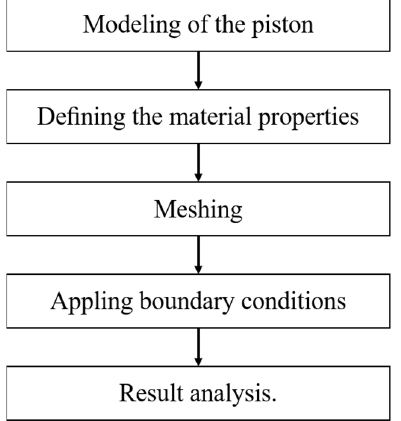
Figure 6. Methodology used for thermal analysis.